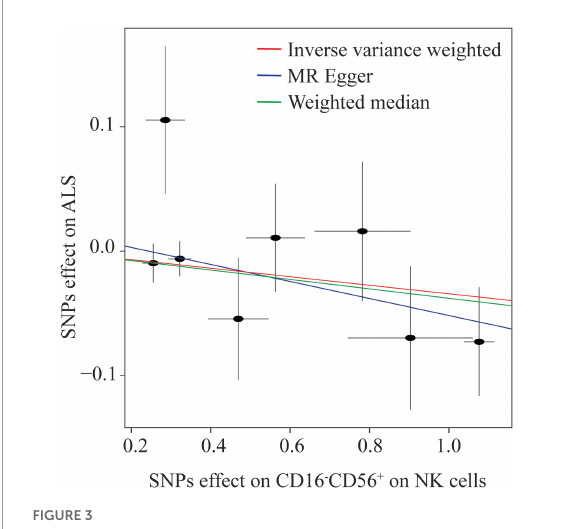
FIGURE3 Scatterplot of single nucleotide polymorphism (SNP) effects on the expression level of CD16 - CD56 + on natural killer (NK) cells versus amyotrophic lateral sclerosis (ALS), with the slope of each line corresponding to the estimated Mendelian randomization effect per method.